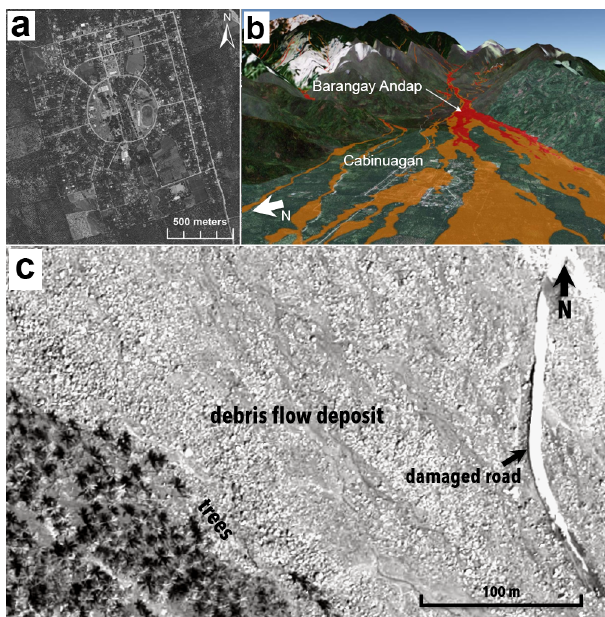
Figure 4. New Bataan. (a) Google image of Cabinuangan (the cen- tral district of New Bataan) before the debris flow. (b) Southward facing three-dimensional terrain diagram of New Bataan, show- ing Cabinuangan and the site of outlying Barangay Andap. (c) A 1m pixel resolution panchromatic Pleiades satellite image of the boulder-rich debris flow deposit in Barangay Andap.